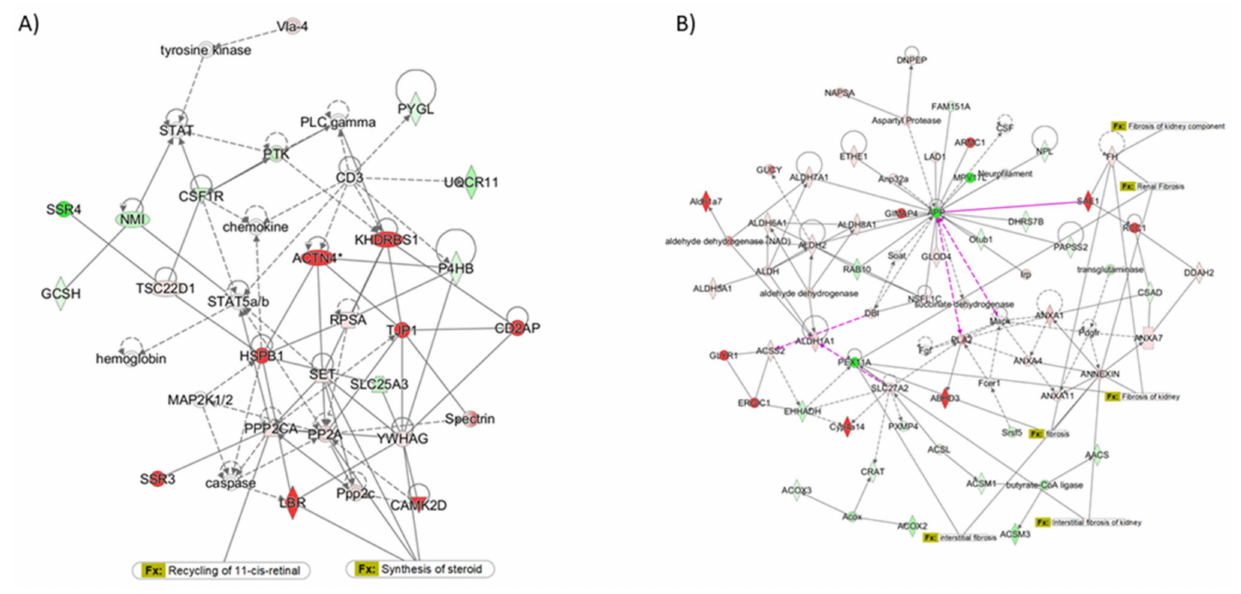
Figure 6. Graphical representation of networks identified by Ingenuity Pathway Analysis (IPA). ( A ) The network of lipid metabolism was merged with energy production and endocrine system disorders. Increased proteins are indicated in red and decreased proteins are indicated in green. ( B ) Graphical representation of the network of glomerular injury. Increased proteins are indicated in red and decreased proteins are indicated in